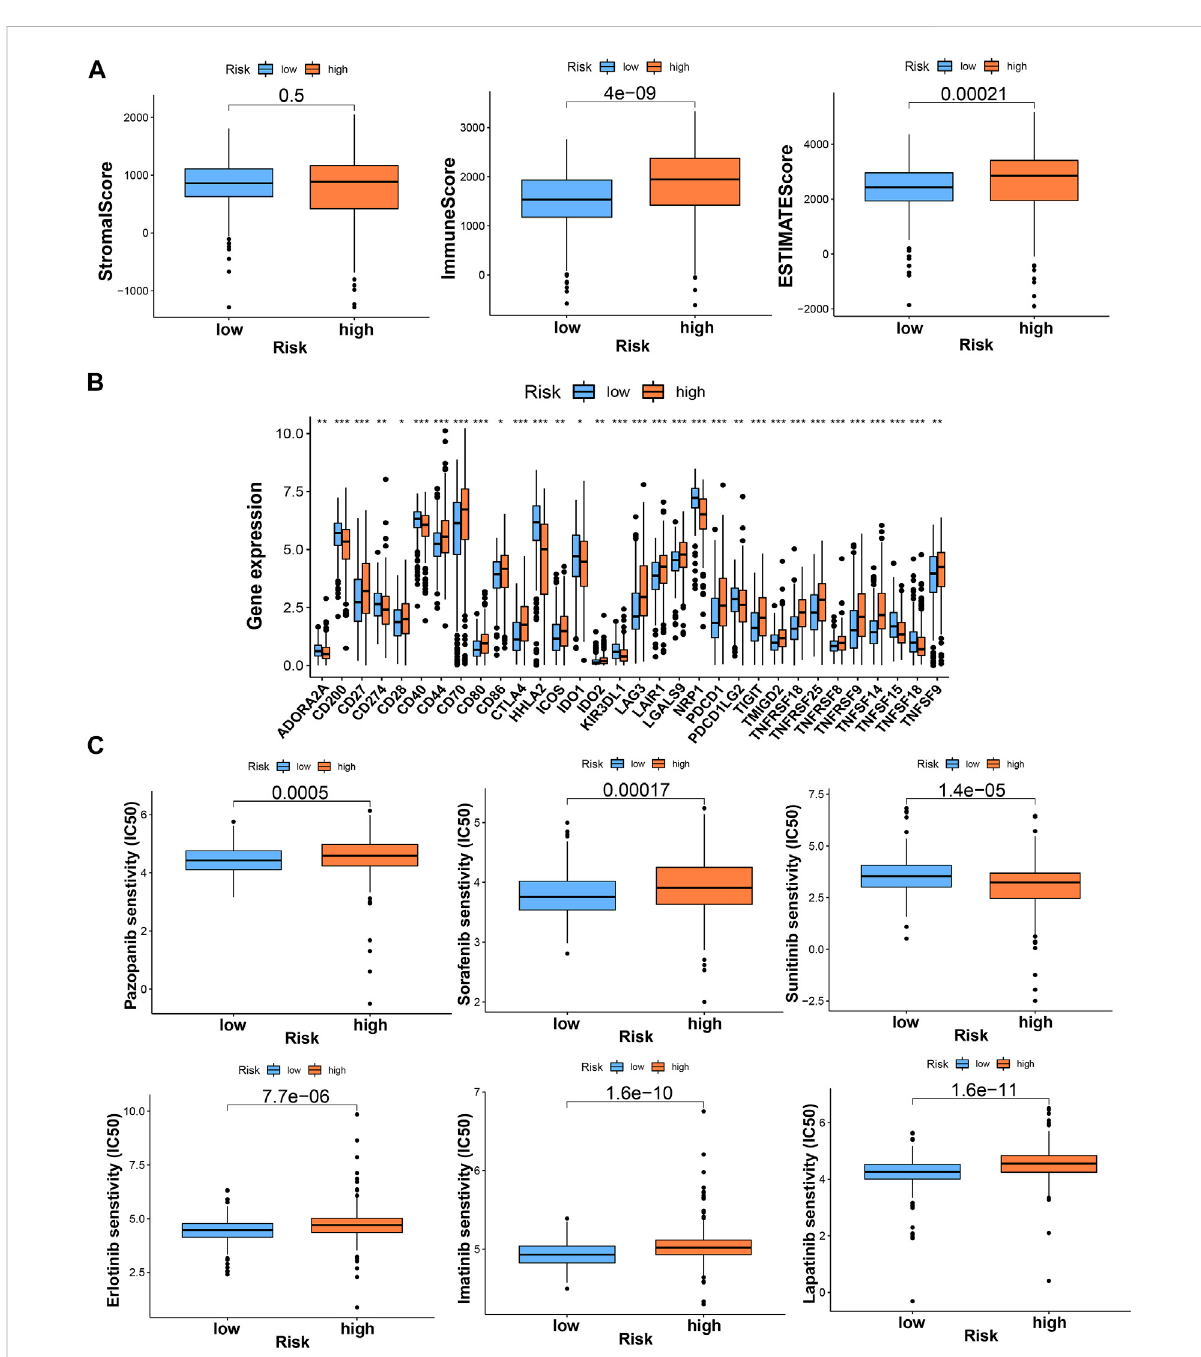
FIGURE 7 The investigation of tumor immune microenvironment and drug sensitivity between the high- and low-risk groups. (A) The comparison of the stromal score, immune score, and estimate score between risk groups; (B) the difference of checkpoints expression between risk groups; (C) some of the drug sensitivity predictions of risk groups. * means p < 0.05; ** means p < 0.01; *** means p <